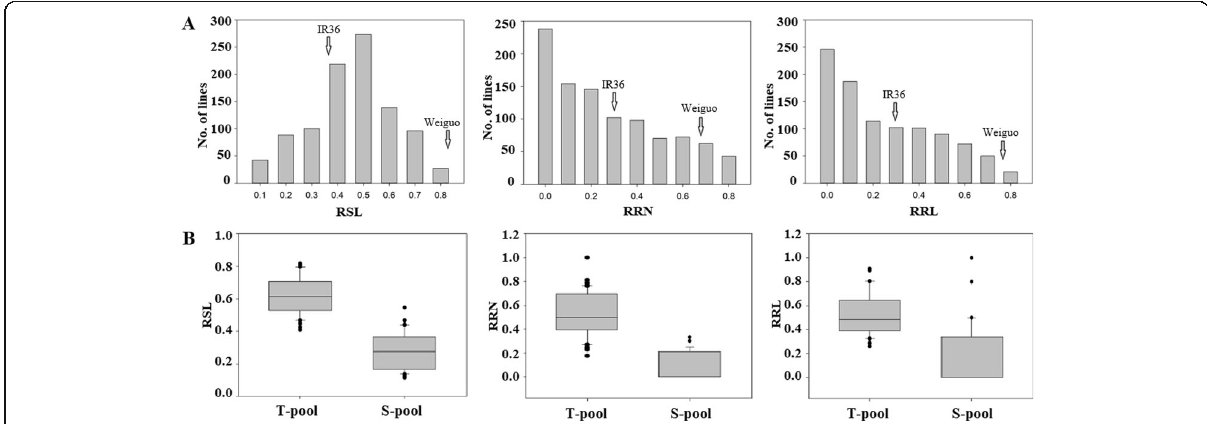
Fig. 1 a Phenotypic distribution of RSL, RRN and RRL of 983 F 2:3 lines. b Box-plot of phenotypic statistical of RSL, RRN and RRL in two pools. RSL: Relative shoot length; RRN: Relative root number; RRL: Relative root length. Arrows indicate the phenotypic value of IR36 and